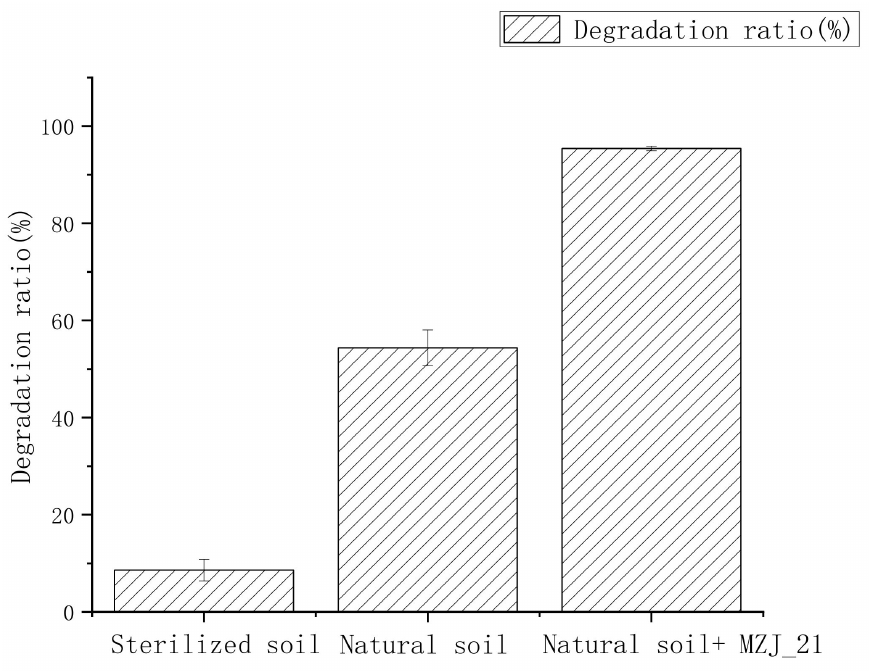
Figure 2. Degradation of phenanthrene in the slurry reactor. Table 1. Number of bacteria in the soil and water of the slurry reactor. Sterilized